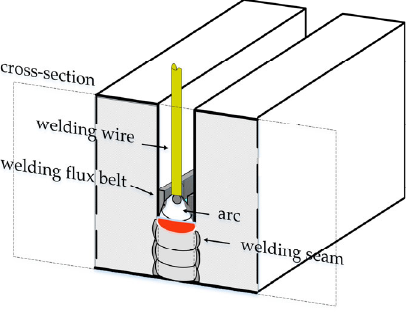
Figure 1. Ultra ‐ narrow gap welding principle diagram.